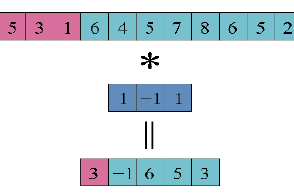
Figure 3. Convolution operation of